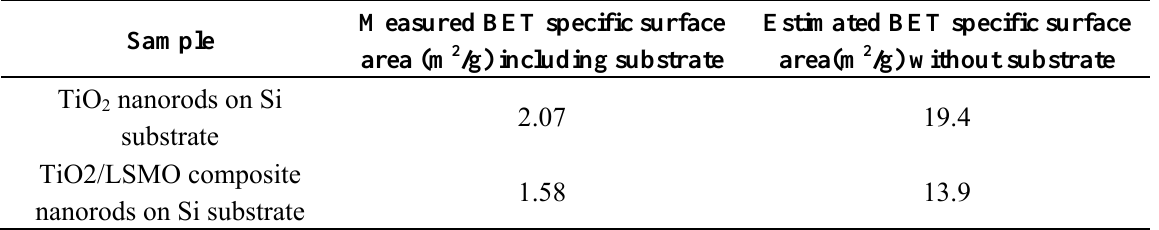
Table 1. Multi-point nitrogen adsorption BET specific surface area of TiO /LSMO composite nanorod array grown on Si and 800 °C annealed TiO 2